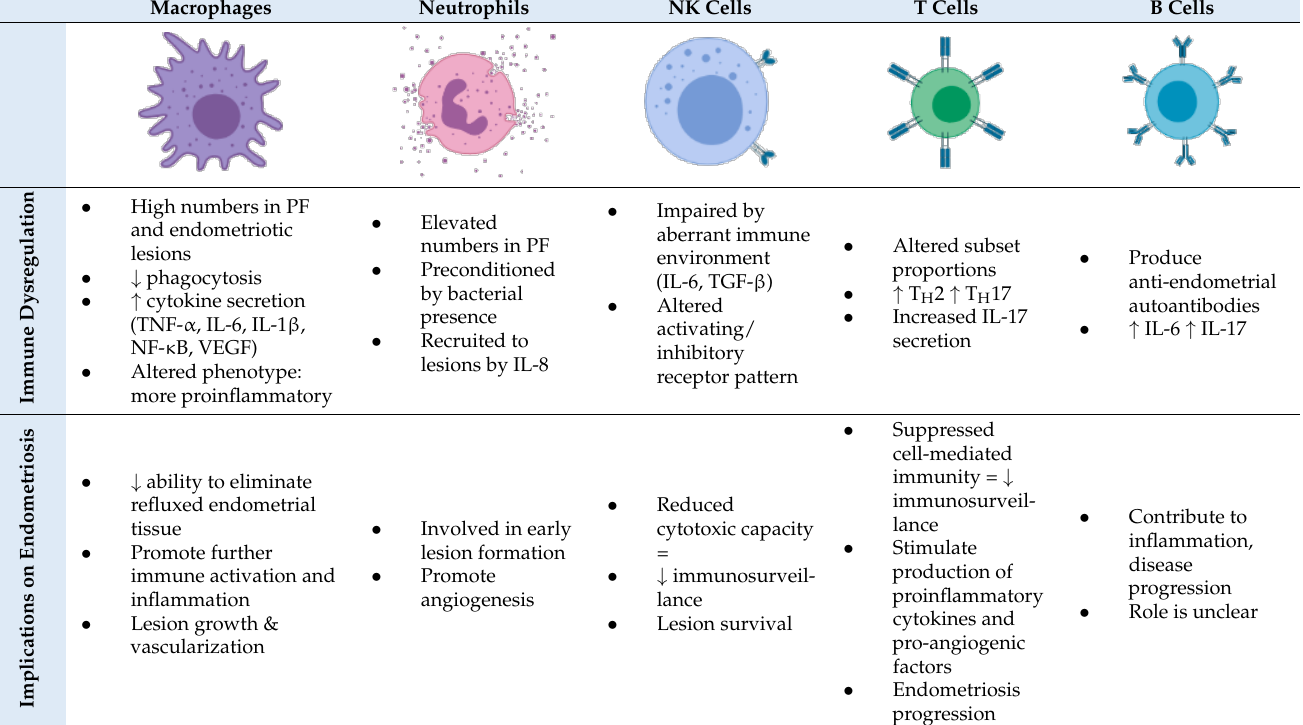
Table 1. Dysregulation of peritoneal innate and adaptive immunity creates environment conducive to endometriosis onset and progression.